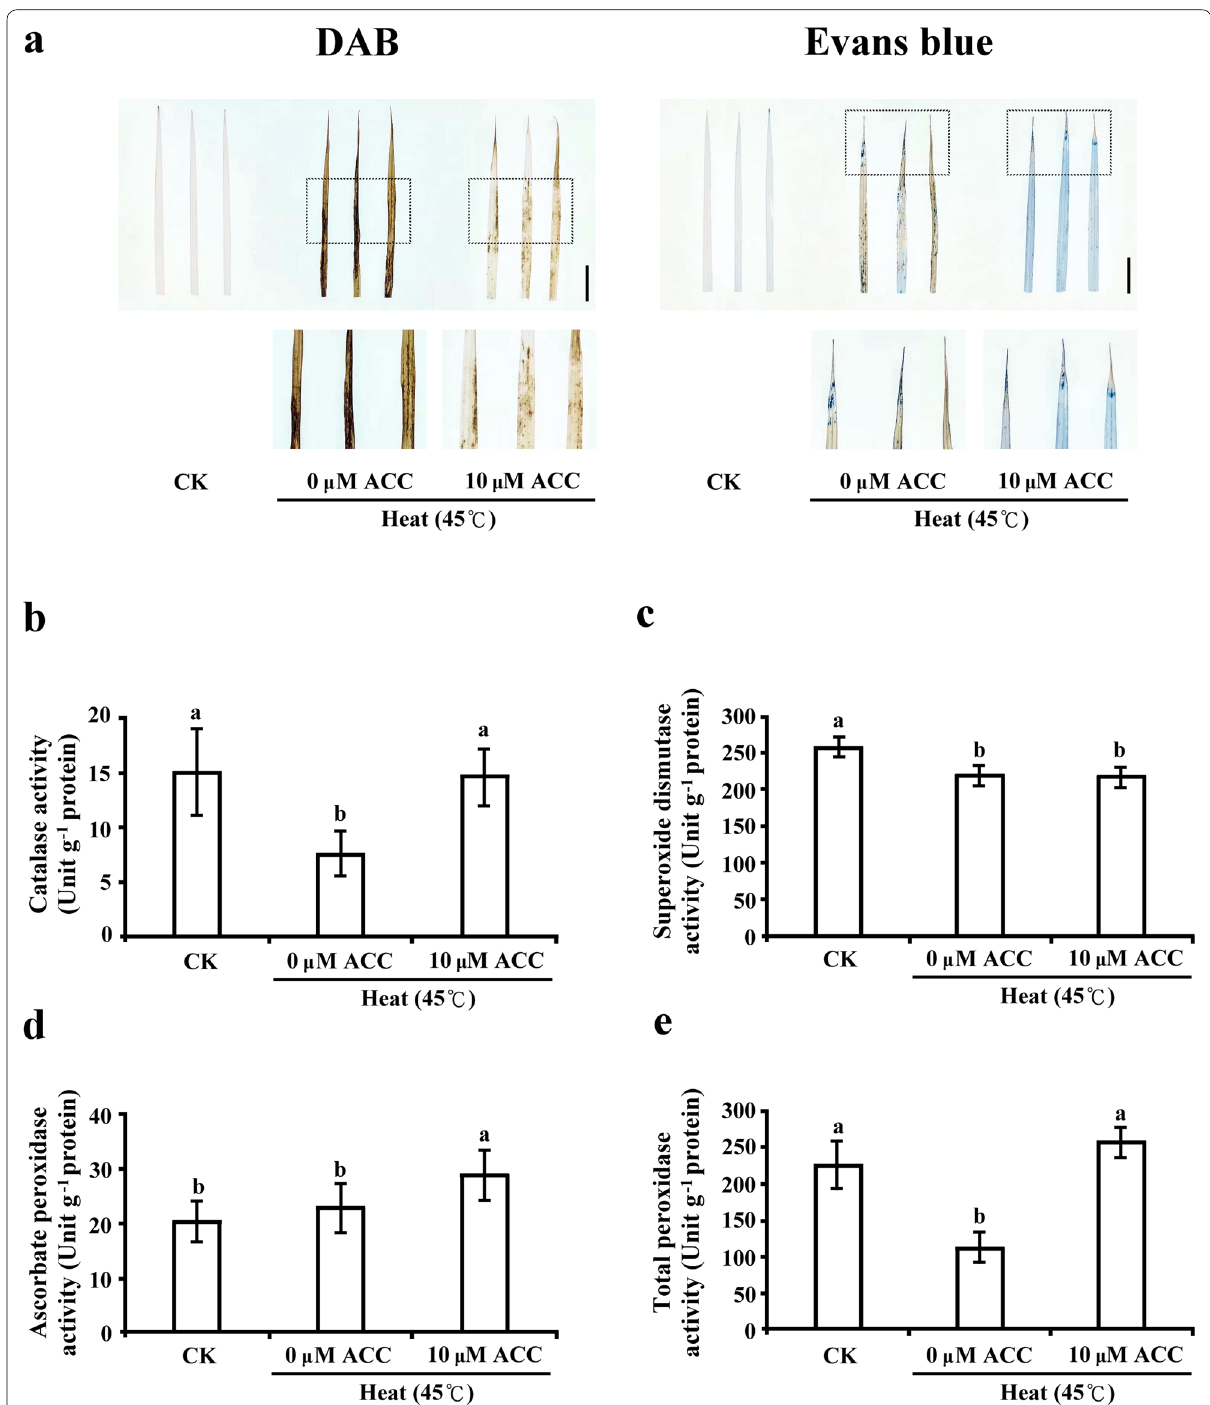
Fig. 3 ROS toxicity, cell death and antioxidant enzyme activity assay in rice seedlings under heat stress combined with ACC treatment. a DAB staining of H 2 O 2 and evans blue staining of cell death in detached leaves of 12 days‑old rice seedlings after treated 45 °C heat stress with or without 10 µM ACC for 4 days. Bar 2 cm. Enzyme activity of catalase ( b ), ascorbate peroxidase ( c ), superoxide dismutase ( d ), and total peroxidase ( e ) in = the shoots of 12‑day‑old rice seedlings was detected after 45 °C heat treatment with or without 10 µM ACC for 4 days. Control check (CK). Values are presented as mean standard deviation based on 30 seedlings of each treatment obtained from six biologically independent experiments. ± Different letters indicate significant difference between the treatments assessed using the LSD post hoc test ( P <